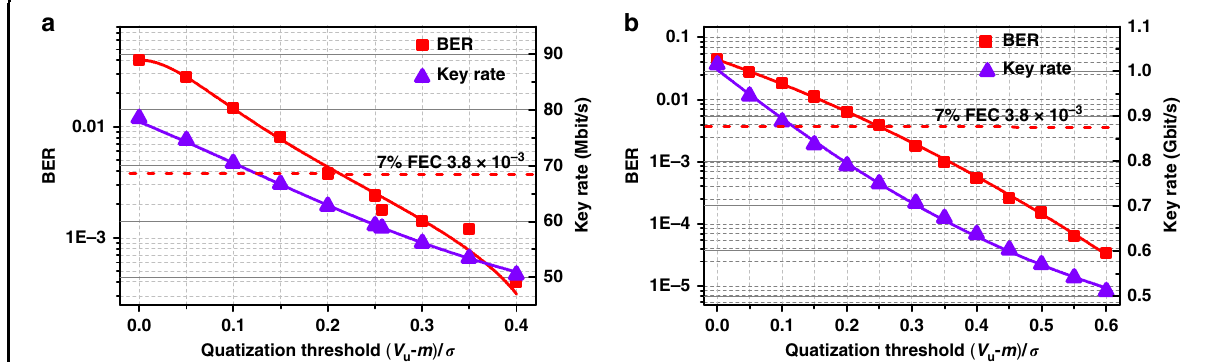
Fig. 5 BER and rate of the fi nal keys as a function of the upper comparison threshold V u . a Same-frequency extraction at 200 Mbit/s and b frequency-multiplication extraction at 3.2 Gbit/s. m and σ are the mean value and standard deviation of chaotic